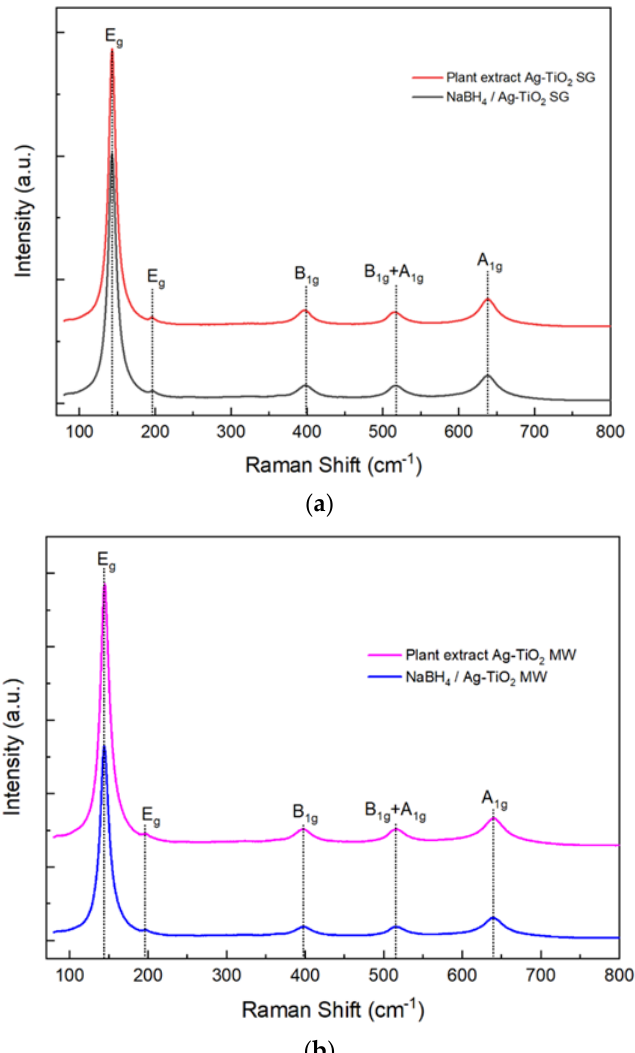
Figure 7. Ag-TiO 2 Raman spectra were synthesized by: ( a ) the sol–gel method and ( b ) the MW- assisted sol–gel method.